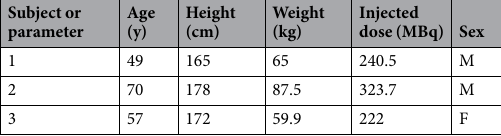
Table 2. Subject